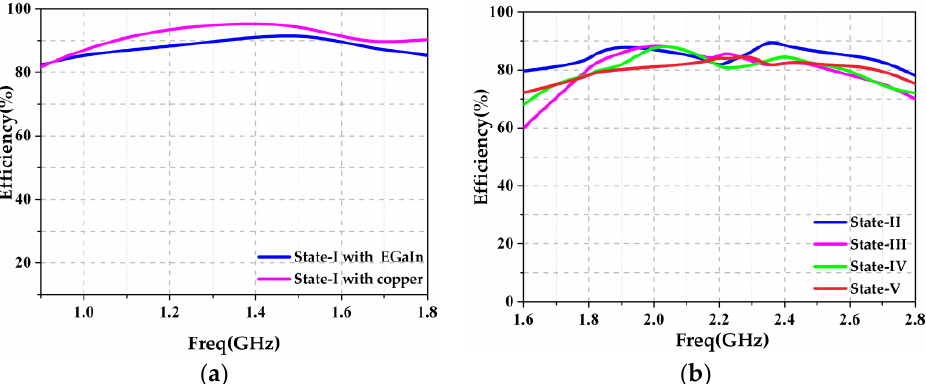
Figure 25. Simulated efficiencies of the designed antenna: ( a ) State-I with copper and EGaIn; ( b ) States-II to -V with EGaIn.